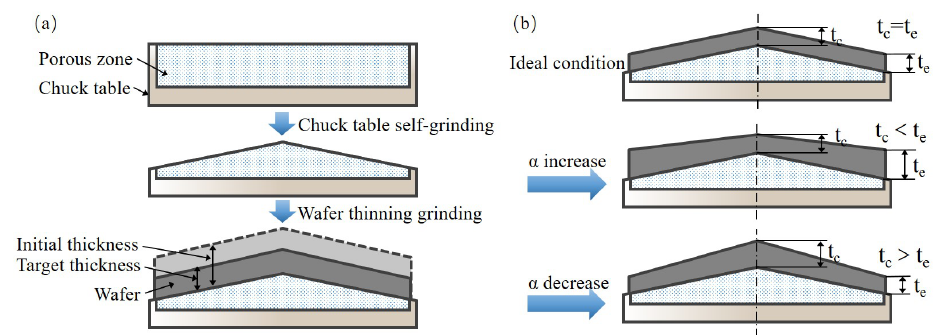
Figure 11. Diagram of the wafer thinning process flow. ( a ) Chuck table dressing and wafer grinding. ( b ) The wafer TTV variation trend caused by space angle variation (taking α and its influence for